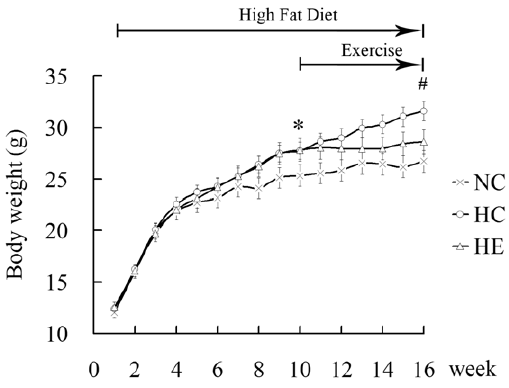
Figure 1. Body weight in the experimental procedure. Values are means 6 SEM (n=6, each group). *: HC (HFD control) vs. NC (normal chow control) p , 0.05; # : HE (HFD exercise) vs. HC p , 0.05.